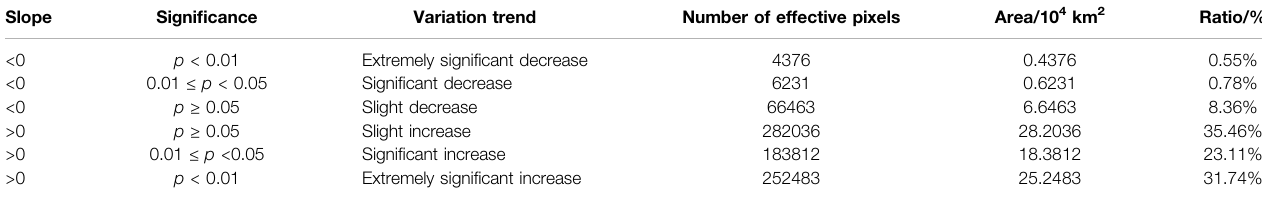
TABLE 2 | The statistical results of the signi fi cance test of NDVI variation trend.